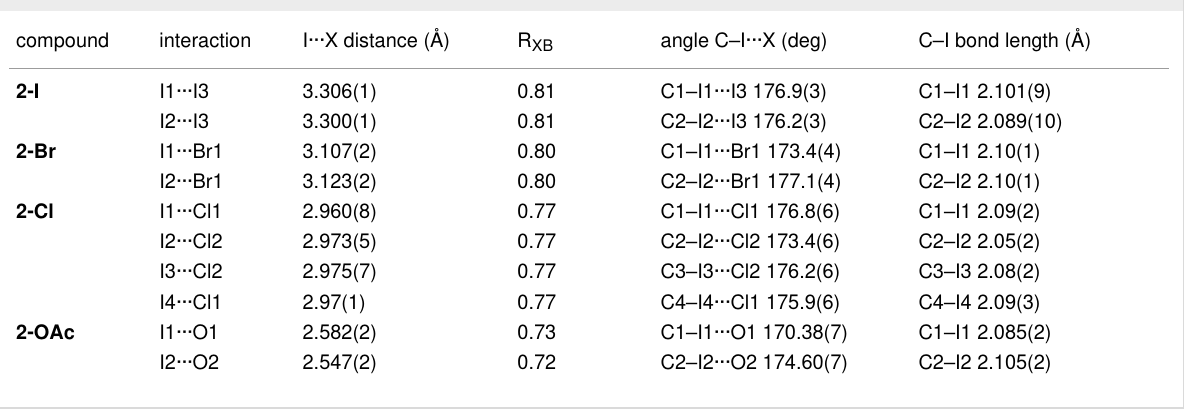
Table 1: XB interactions of the crystals. compound